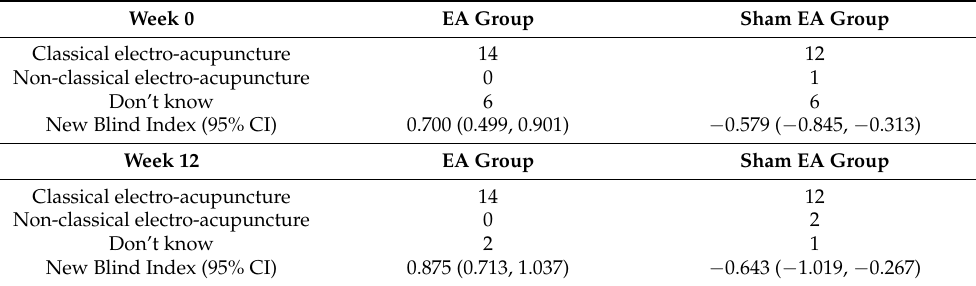
Table 6. Blinding